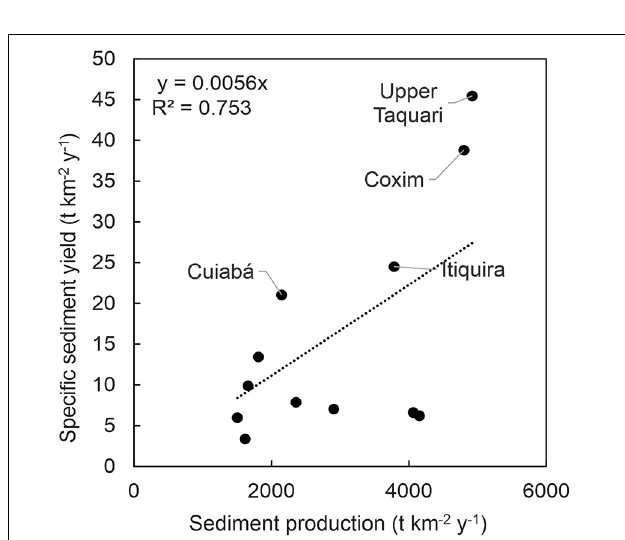
FIGURE 7 | Comparison of specific sediment yields measured in rivers near their points of entry into the Pantanal to potential sediment production in their watersheds as estimated using the SWAT model (Mingoti et al.,